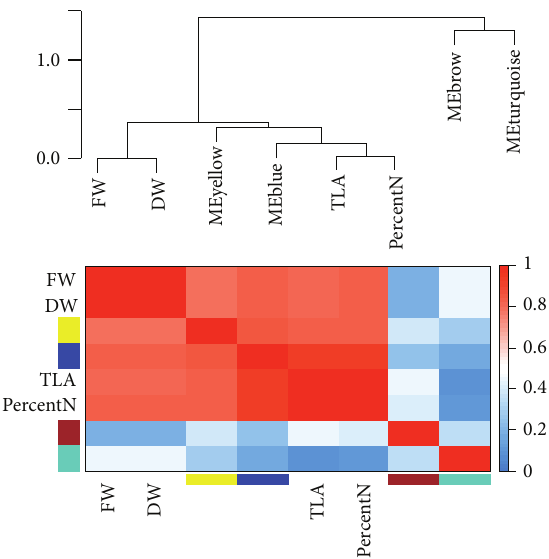
Figure 5: Module eigengene network and its relationship with growth traits. The dendrogram on the top illustrates the relationship among the module eigengenes and traits total leaf area (TLA), fresh weight(FW),frozenweight(DW),andpercentnitrogen(PercentN). Each row and column on the heat map correspond to a module or a trait. The color of the cell indicates the adjacencies among the module eigengenes and traits; dark red color indicates close ardencies and dark blue no or little